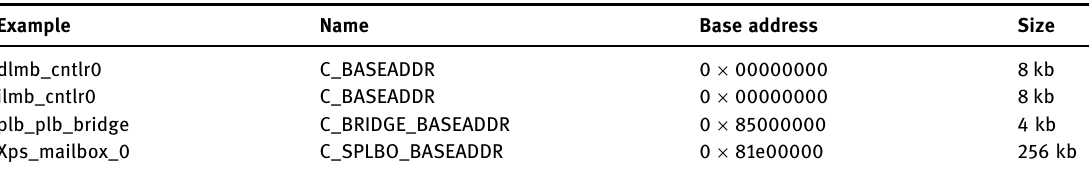
Table 3: Spatial addresses of dual - core systems based on Mailbox